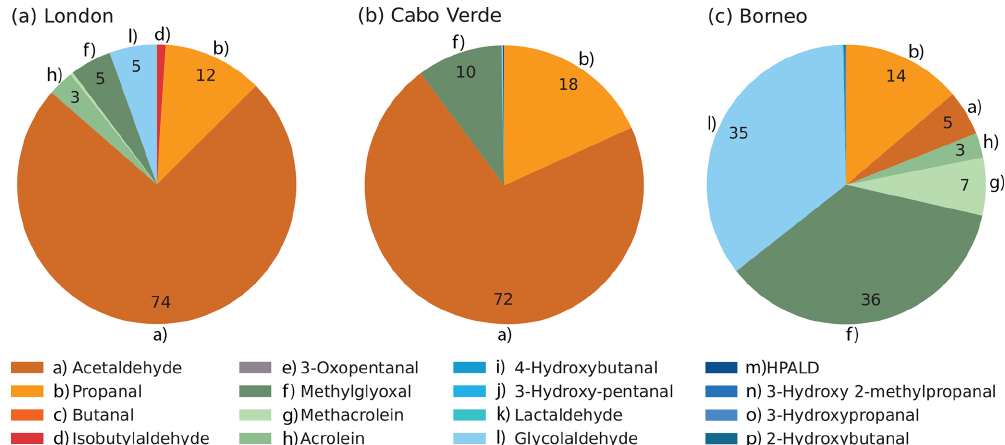
Figure 1. Average daytime percentage contribution of individual aldehydes to the total production of H 2 from aldehydes (exclud- ing formaldehyde and glyoxal) assuming a 1% quantum yield, estimated for the (a) London, (b) Cabo Verde and (c) Borneo sites using the box model. The daytime average H 2 rates of production from all aldehydes (including formaldehyde and glyoxal) were 6 . 35 × 10 6 molec.cm − 3 s − 1 for London, 6 . 45 × 10 5 molec.cm − 3 s − 1 for Cabo Verde and 6 . 64 × 10 5 molec.cm − 3 s − 1 for Borneo. These rates were calculated for the length of the simulation at each site (see Table